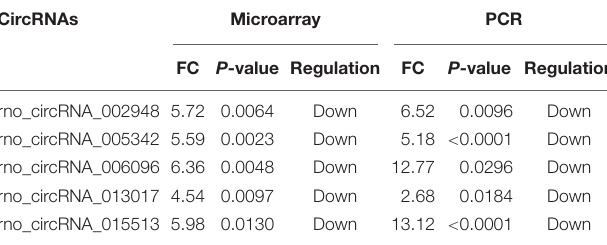
TABLE 3 | Comparison for candidate circRNAs expression in microarray and